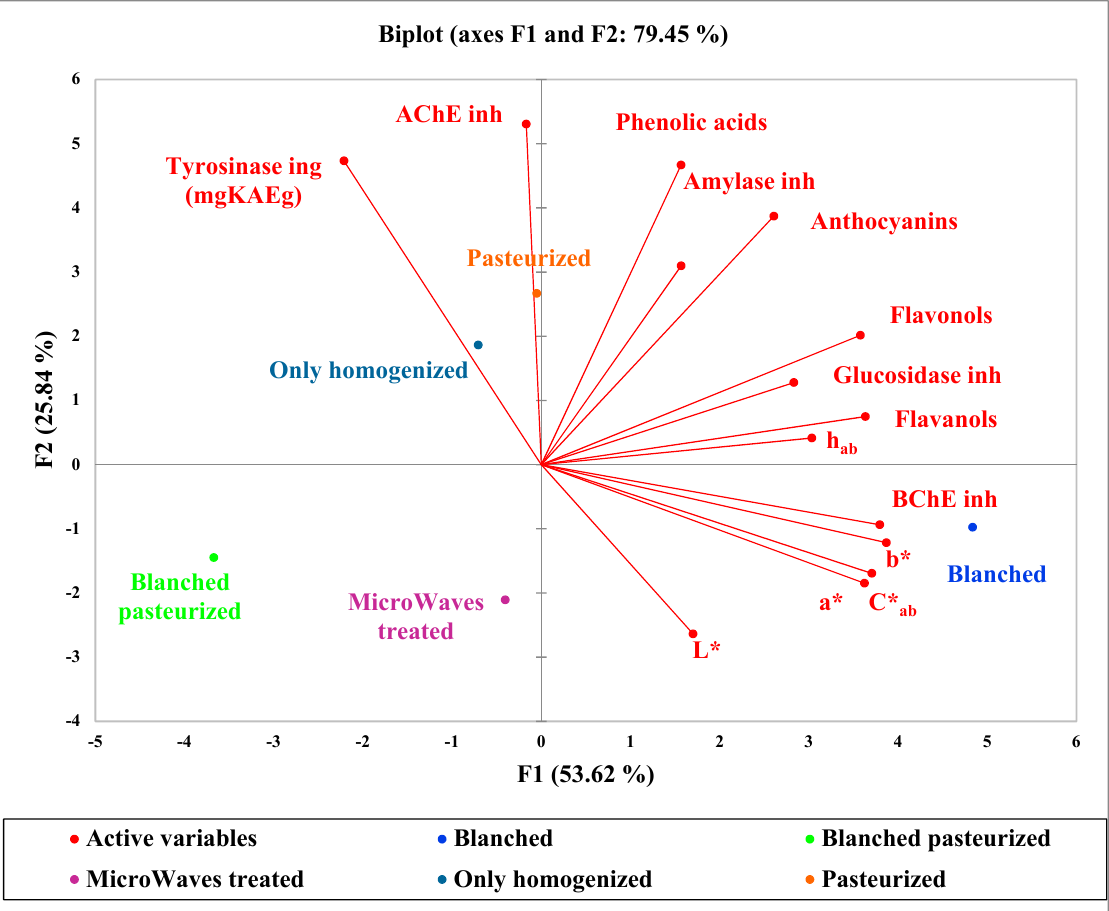
Figure 3. Principal component analysis (PCA) plots of the fresh analyzed Clery graft samples evaluated as series.